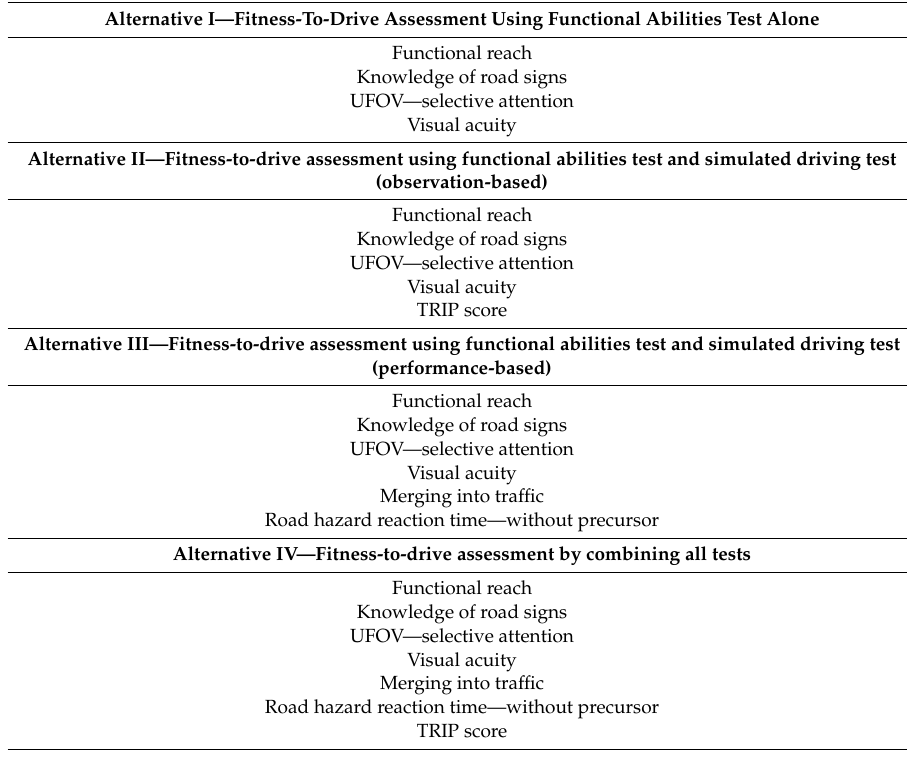
Table 3. Di ff erent variables used in the designated